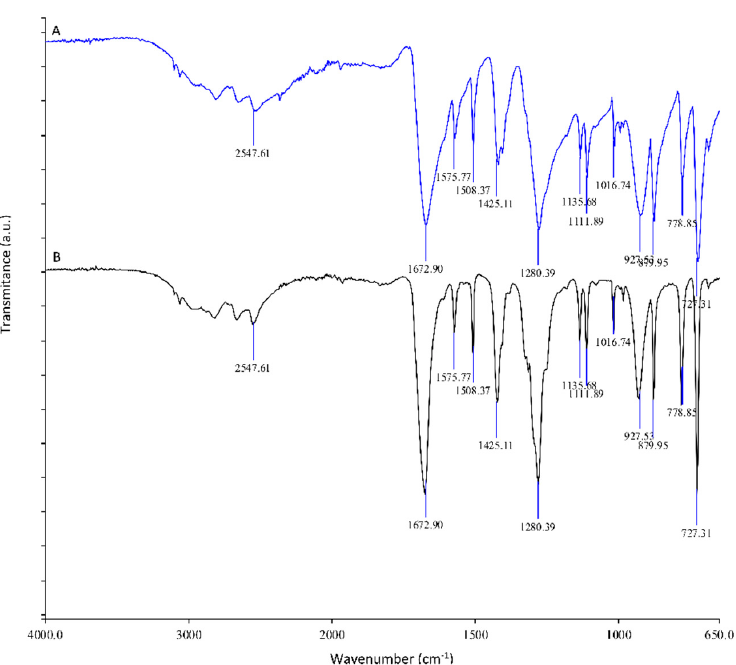
Figure 9. ATR–FTIR spectra of commercially available pure TPA (A spectrum), isolated solid fraction after alkaline hydrolysis, and addition of acid of PET foil coated with chitosan (B spectrum).